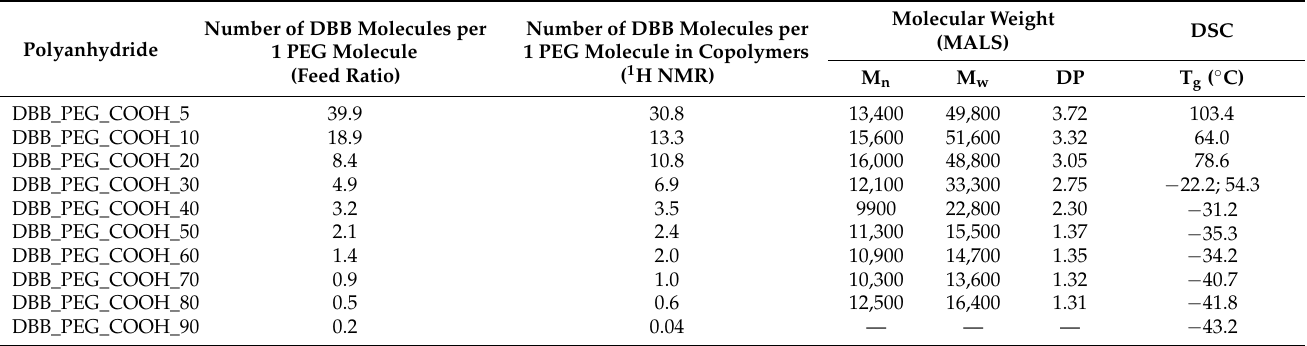
Table 1. Characteristic of branched polyanhydrides.